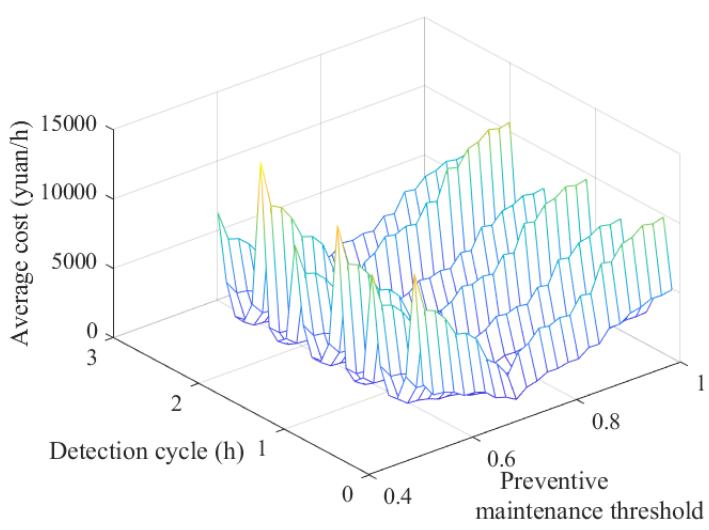
Figure 10. Relationship between variables of joint optimization model and average cost .